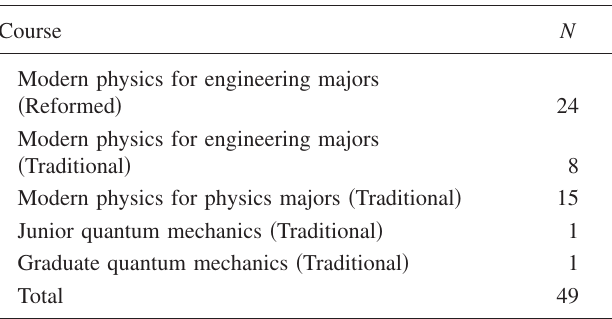
TABLE I. Courses from which students were drawn for inter- views. N is the number of students interviewed from each course. The numbers for the first three courses include students from sev- eral different semesters of the same course. Course